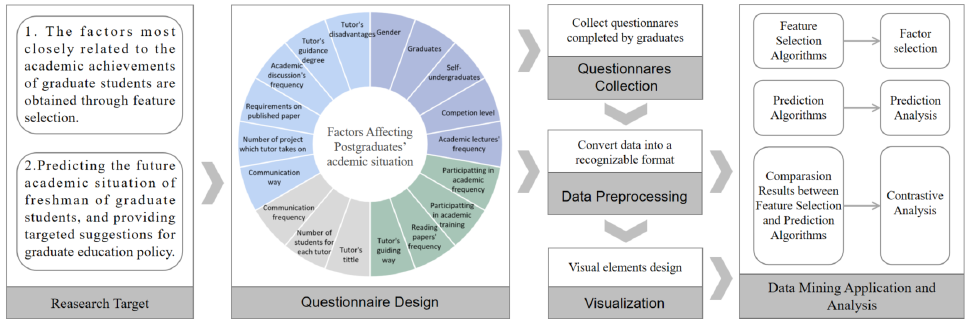
Figure 1. The pipeline of our system for data mining and visual analysis of graduates’ training